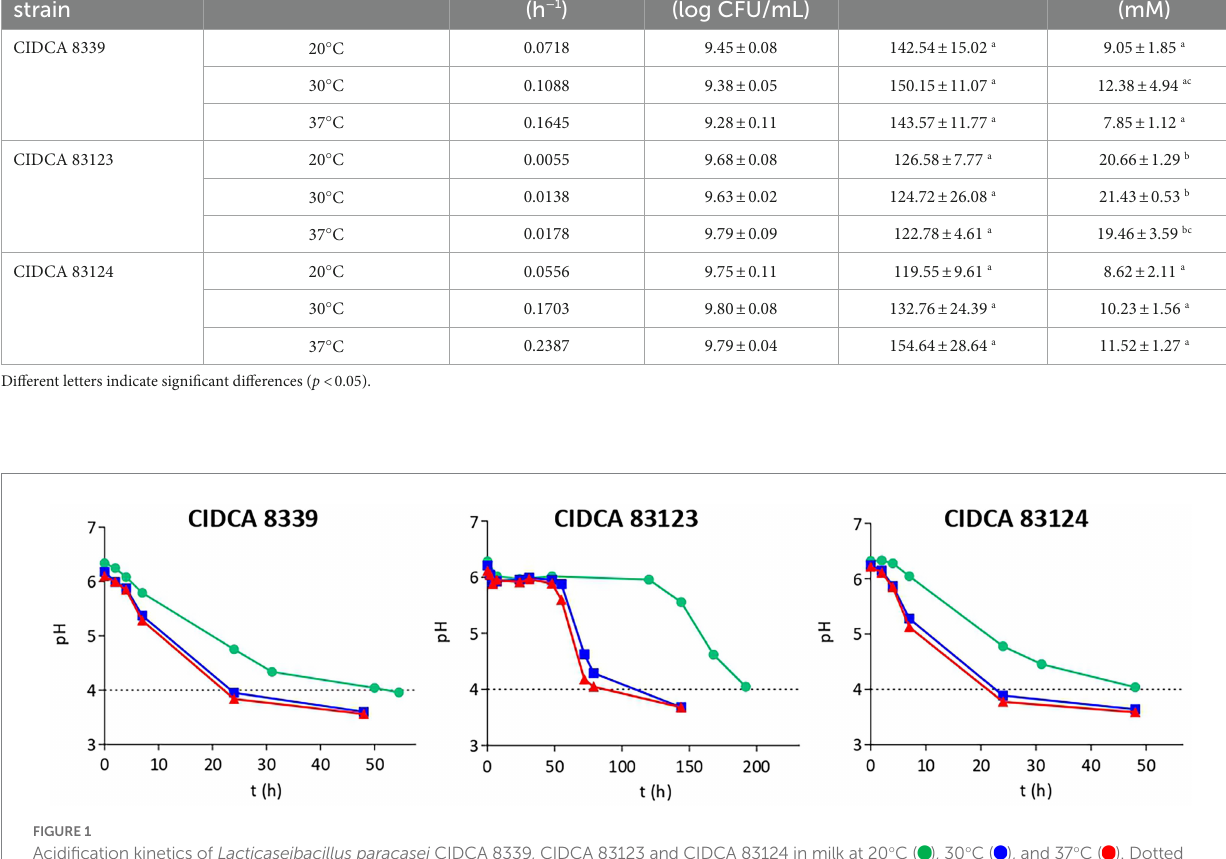
TABLE 1 Bacteria growth rate and yield, lactic and acetic acid concentration of milk fermented with Lacticaseibacillus paracasei CIDCA 8339, CIDCA 83123, and CIDCA 83124 at 20 ° C, 30 ° C, and 37 ° C. L. paracasei strain